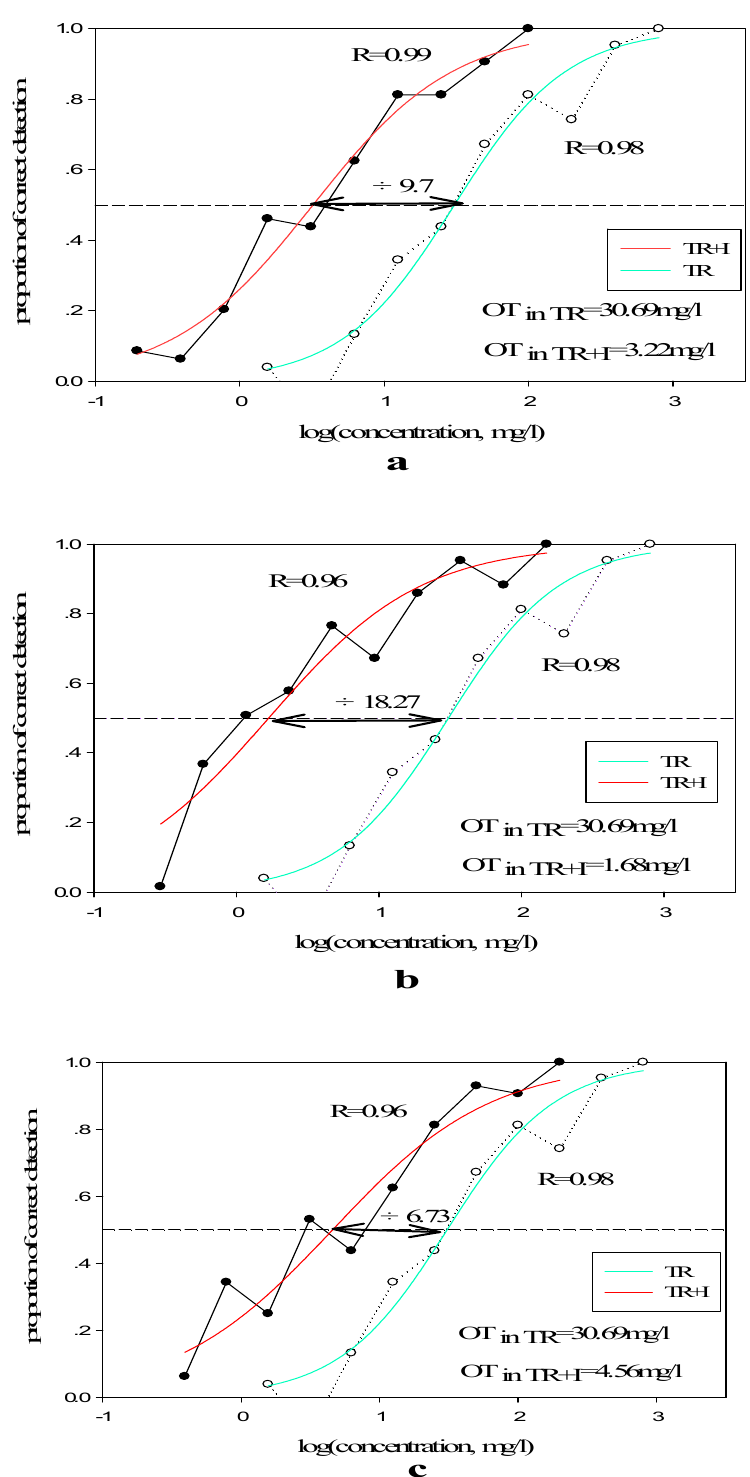
Figure 4. Aromatic effect of alcohols at different concentrations added to terpenes recombination. I, isoborneol. ( a – c ) Adding isoborneol at high, medium, and low level respectively.